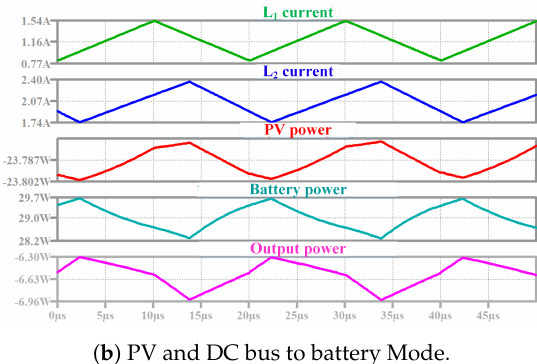
Figure 15. Simulation results of Type I-III-IA.